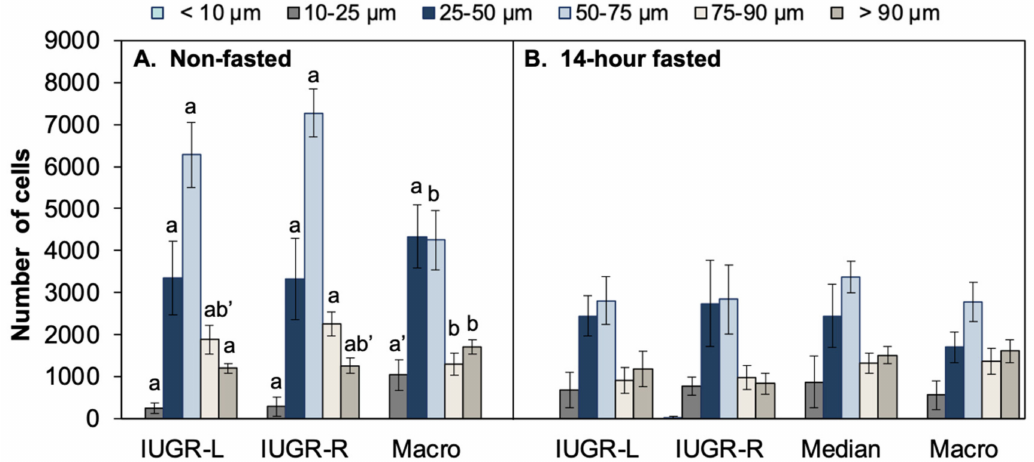
Figure 7. Gonadal adipocyte size distribution. Distribution of size categories for gonadal adipocytes collected from ( A ) non-fasted and ( B ) 14-h fasted males. For non-fasted males ( A ), the IUGR-L and IUGR-R males had significantly more mid-size adipocytes relative to macrosomic males, while macrosomic males had more of the largest adipocytes. a’ p < 0.1; b’ p < 0.08. For the 14-h fasted males, there were no significant differences between males from the different birth weight categories in any of the size categories ( B ). Different letters indicate statistically significant differences between birth weight groups within a size category ( p < 0.05); groups that share a letter in common are not statistically different; letters with a dash indicate p values between 0.05 and 0.01 as indicated above. Values are mean ±